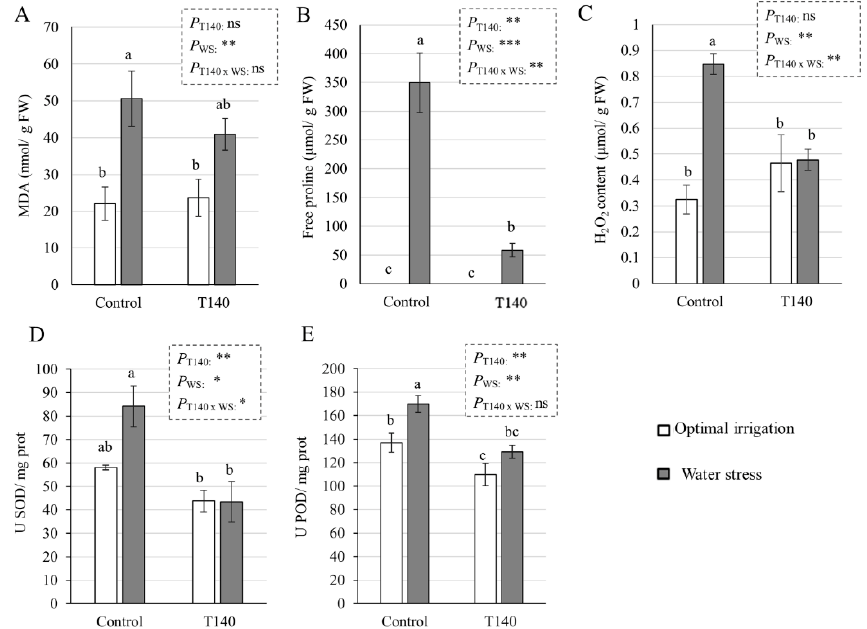
Figure 5. Effect of strain T140 on ( A ) MDA, ( B ) free proline, ( C ) H 2 O 2 content, ( D ) SOD, and ( E ) POD antioxidant activities of 4-week-old wheat plants grown under optimal irrigation and water stress (WS) (irrigation withdrawn during the third and fourth weeks) conditions. Data were calculated from three replicates for each treatment and irrigation condition ( n = 3), and different letters above the bars indicate significant differences according to one-way analysis of variance (ANOVA) followed by Tukey’s test ( p < 0.05). For each set of data, a significant effect was determined using a two-way ANOVA for “T140 application”, “WS”, and their combination (***: p < 0.001; **: p < 0.01; *: p < 0.05; ns: no statistical differences). MDA: malondialdehyde, SOD: superoxide dismutase, and POD: peroxidase.